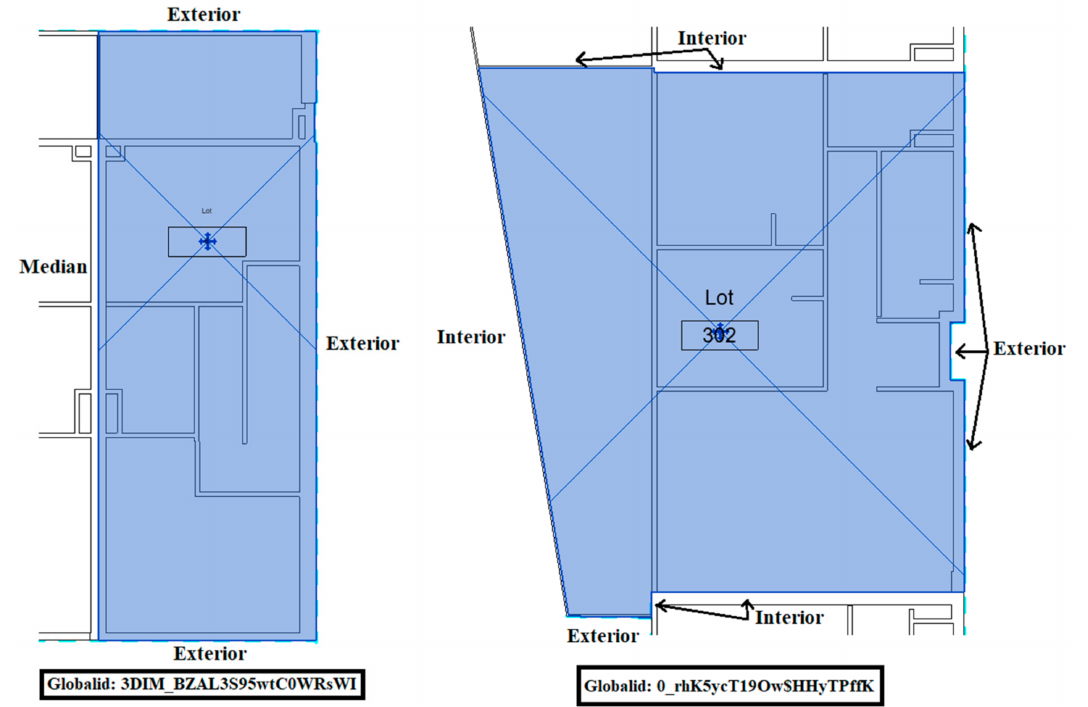
Figure 21. Depiction of property boundaries for two lots on the 2D floor plan view of Building Information Modelling (BIM) models.